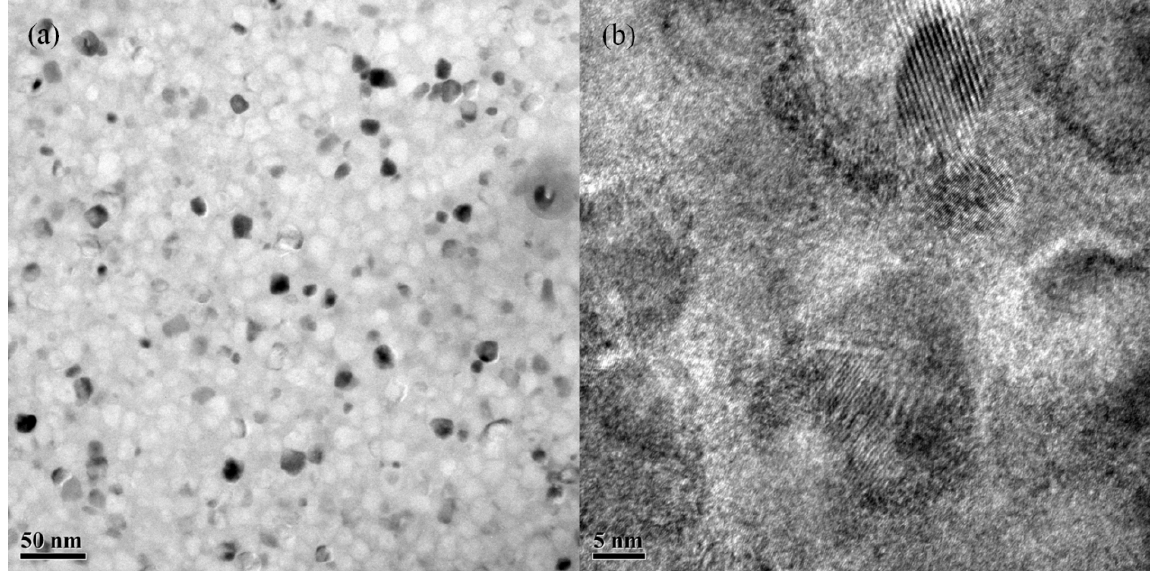
Figure 3. TEM morphology of 1.0% Gd sample. ( a , b ) for different magnifications.